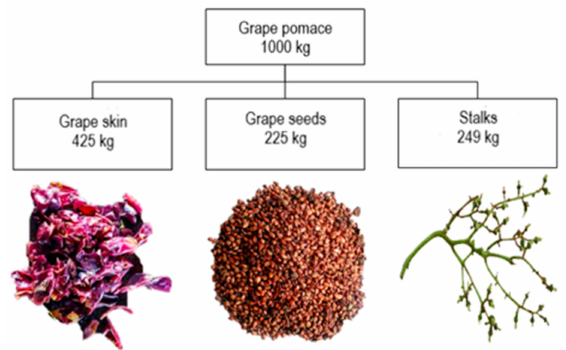
Figure 1. Composition of grape pomace reported to 1000 kg [1].